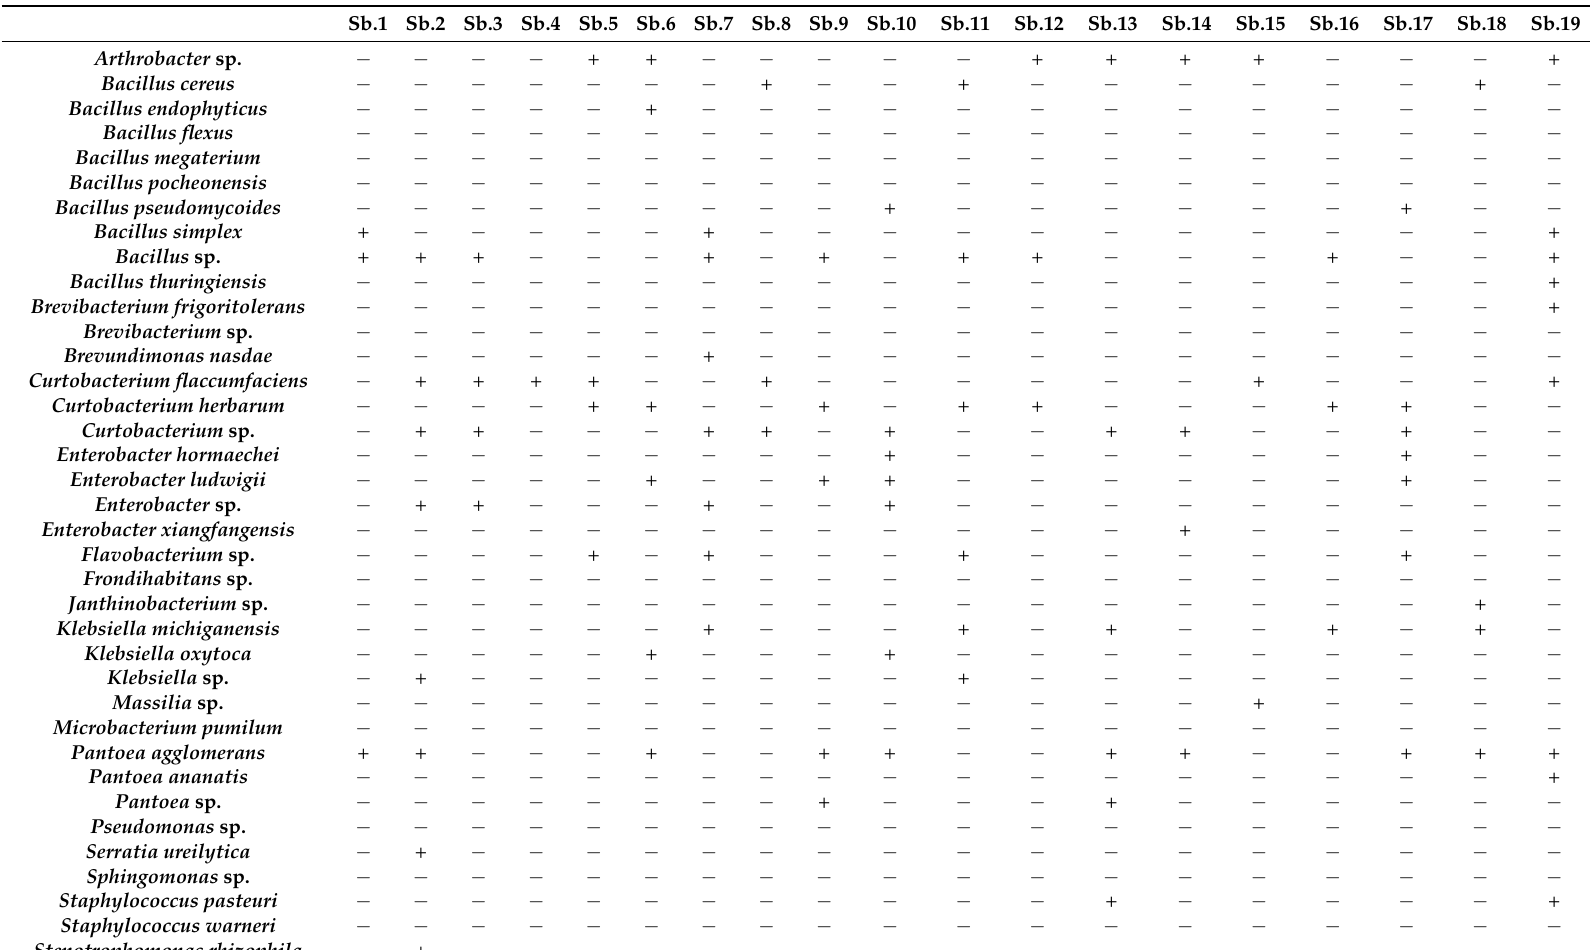
Table 4. Bacteria species isolated from Sylvia